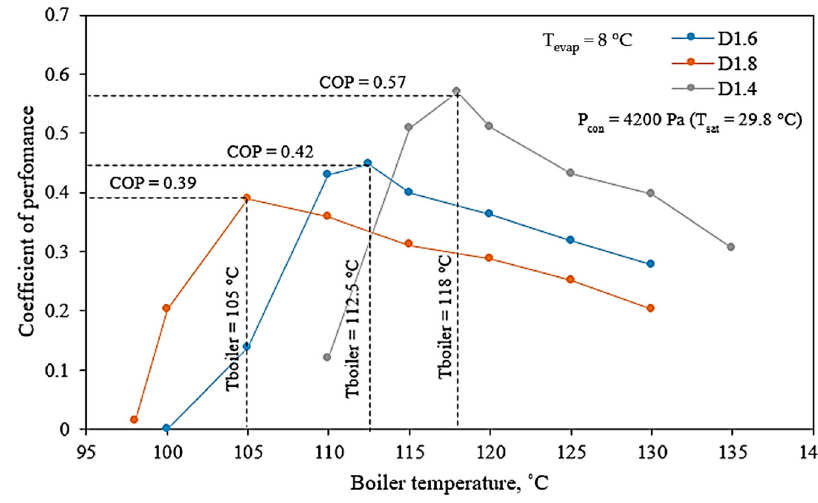
Figure 8. Impact of the primary nozzle throat (ejector area ratio). As proposed above, under the ejector area ratios of between 65 and 107, the optimal performance is produced under the boiler temperature between 105 and 118 ◦ C,